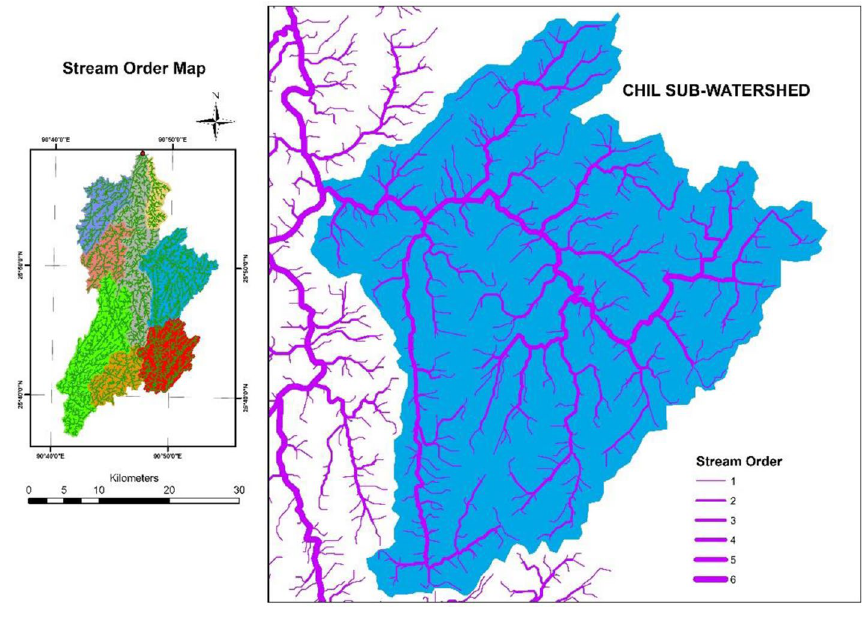
Fig. 3 Stream order map of the study